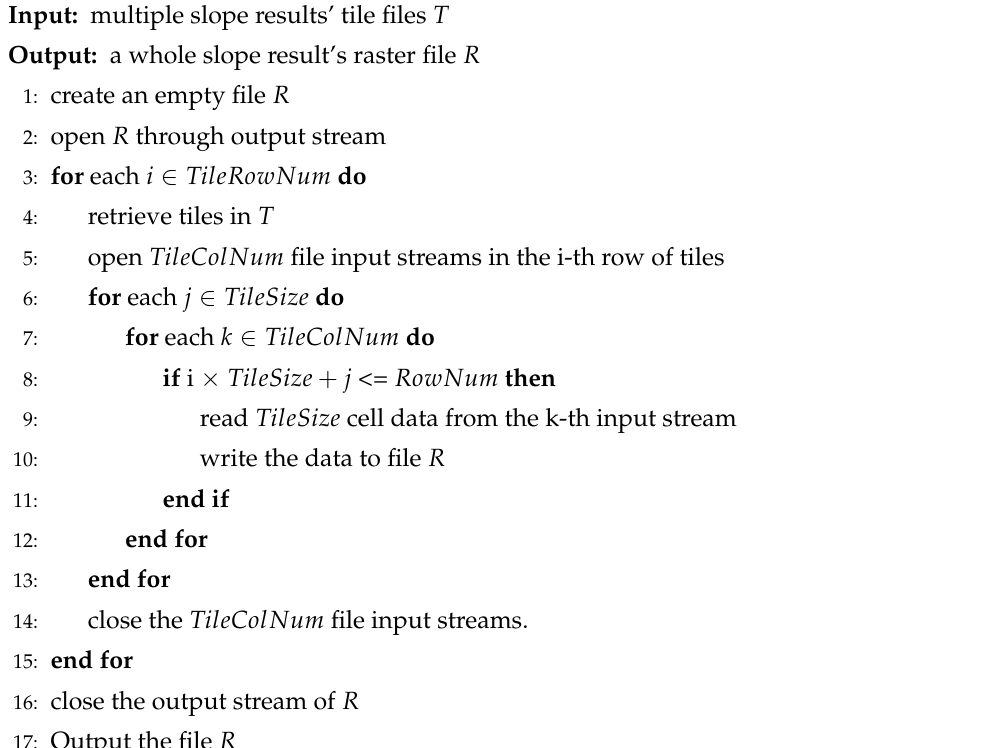
Algorithm 2 Data merging algorithm